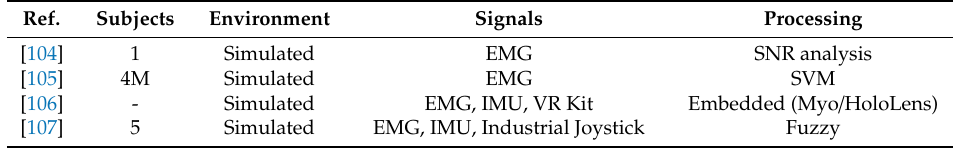
Table 3. Overview of EMG human–machine interaction (HMI) myoelectric control systems experimental setups in production engineering.